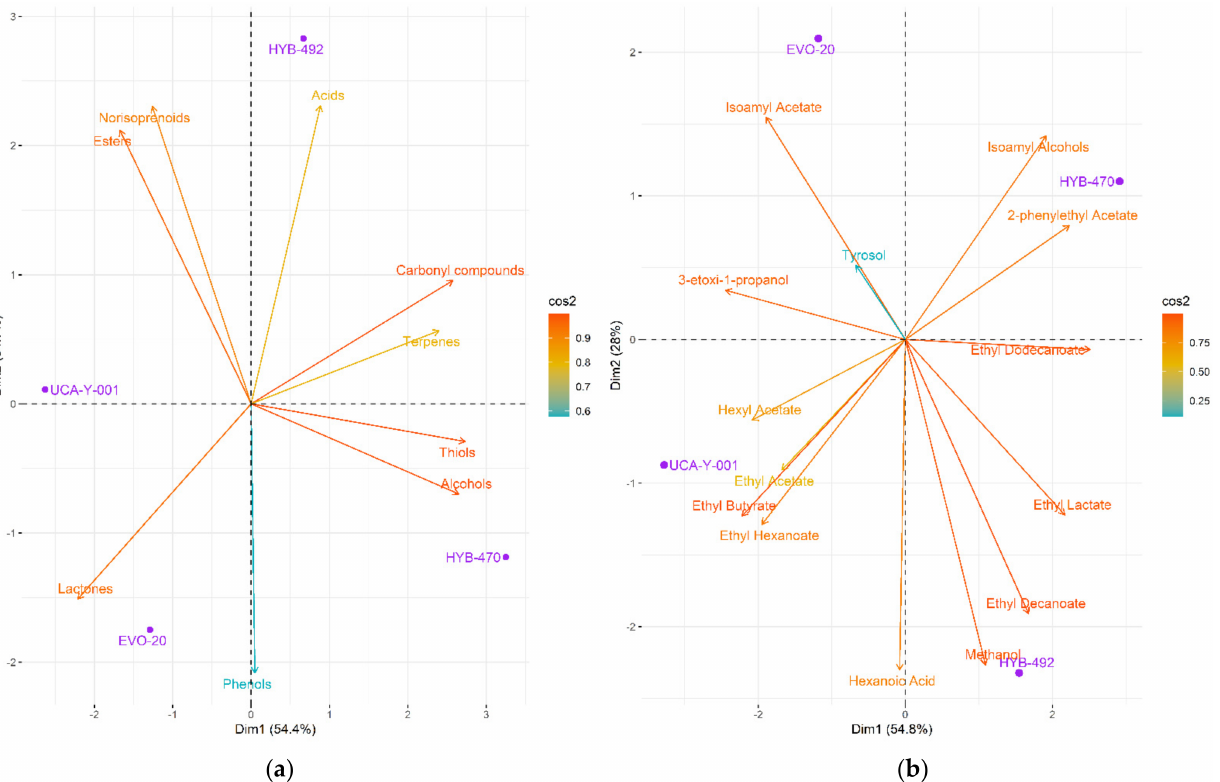
Figure 3. Principal component analysis of the volatile composition data of the industrial wines fermented with the different yeast strains studied (UCA-Y-001 as control, EVO-20, HYB-470, and HYB-492), using as variables: ( a ) chemical groups; ( b ) individual metabolites (on the plane, PC1 against